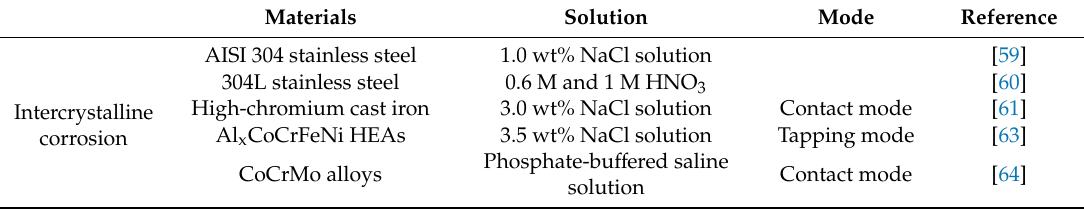
Table 5. Summary of the application of EC-AFM in intercrystalline